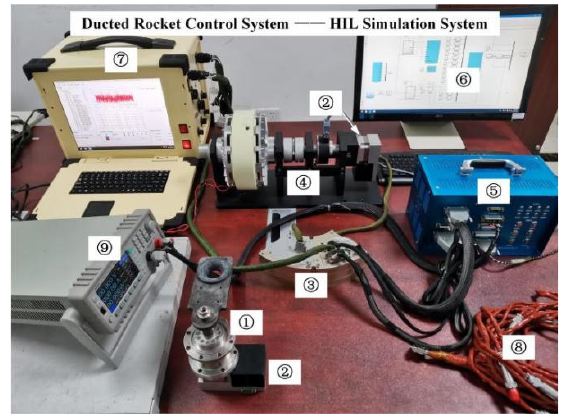
Figure 13. Hardware in loop simulation system for the ducted rocket [12] ① Flow Regulator valve; ② Flow Regulator Motor; ③ Controller ; ④ Load Simulation Device ; ⑤ Real-Time Simulation De- vice ; ⑥ Simulation Station ; ⑦ Ground Test Device ; ⑧ Sensor Cable ; ⑨ System Power.